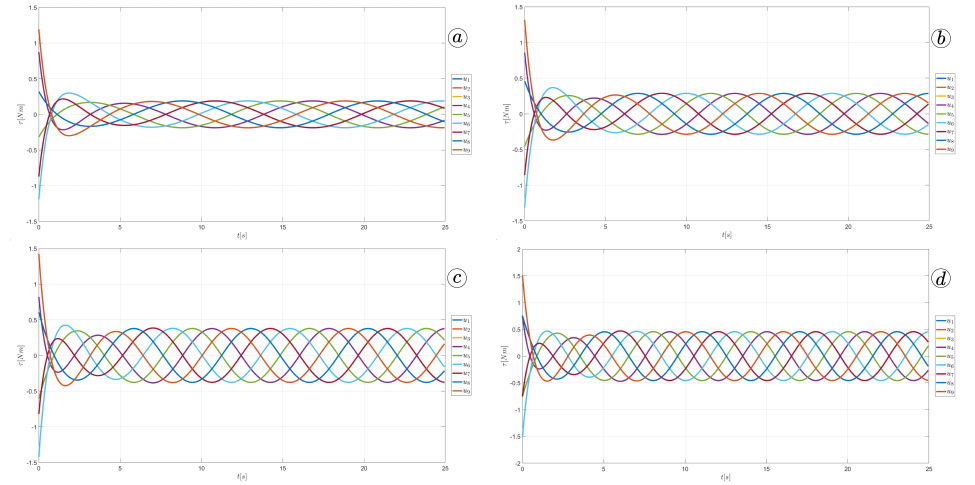
Figure 33. Torque in robot’s joints for ω = 30 ◦ ( a ), ω = 40 ◦ ( b ), ω = 50 ◦ ( c ), and ω = 60 ◦ ( d